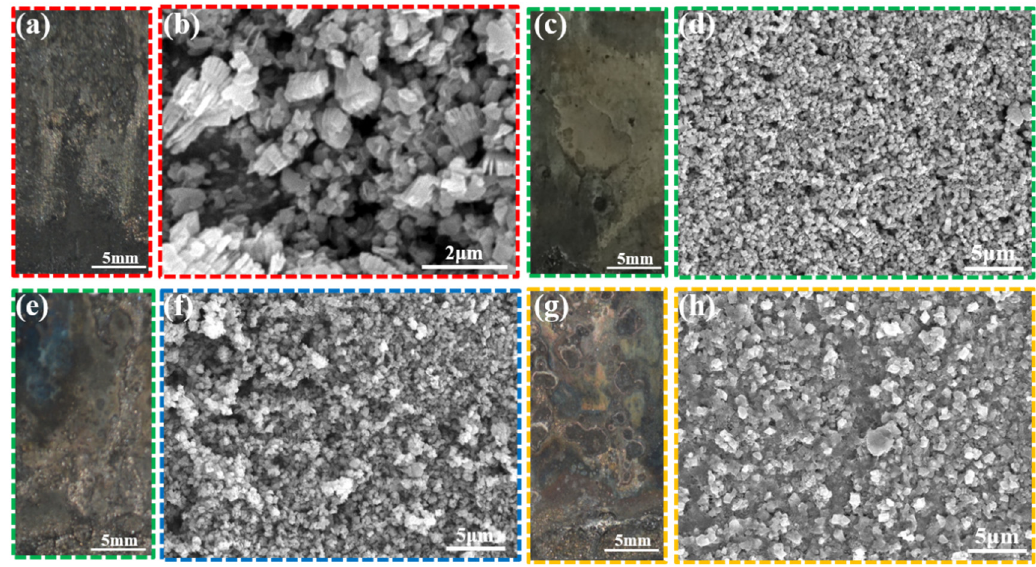
Figure 9. Macro ‐ morphology and micro ‐ morphology of T95 steel used for wellbore at various tem ‐ Figure 9. Macro-morphology and micro-morphology of T95 steel used for wellbore at various perature in the gas phase ( a , b ): 60 °C; ( c , d ): 90 °C; ( e , f ): 120 °C; ( g , h ): 150 °C). temperature in the gas phase (( a , b ): 60 ◦ C; ( c , d ): 90 ◦ C; ( e , f ): 120 ◦ C; ( g , h ): 150 ◦